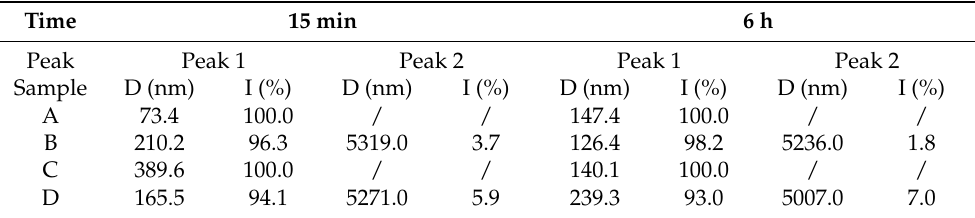
Table 8. The diameter and intensity of the peaks in size distribution curves obtained for the samples of the dissolution medium during the in vitro drug release testing of the tablets